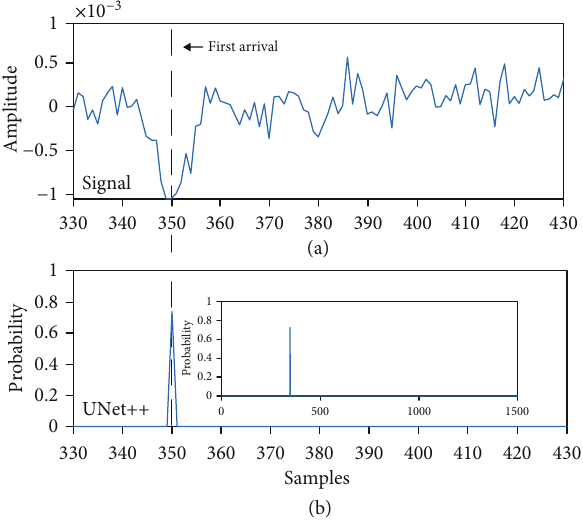
Figure 9: First-arrival picking result of the noise-free forward simulated signal. (a) Local ampli fi cation of the signal waveform in the range of 330 ms to 430 ms. (b) The picking result in the range from 330 ms to 430 ms obtained by the UNet++.